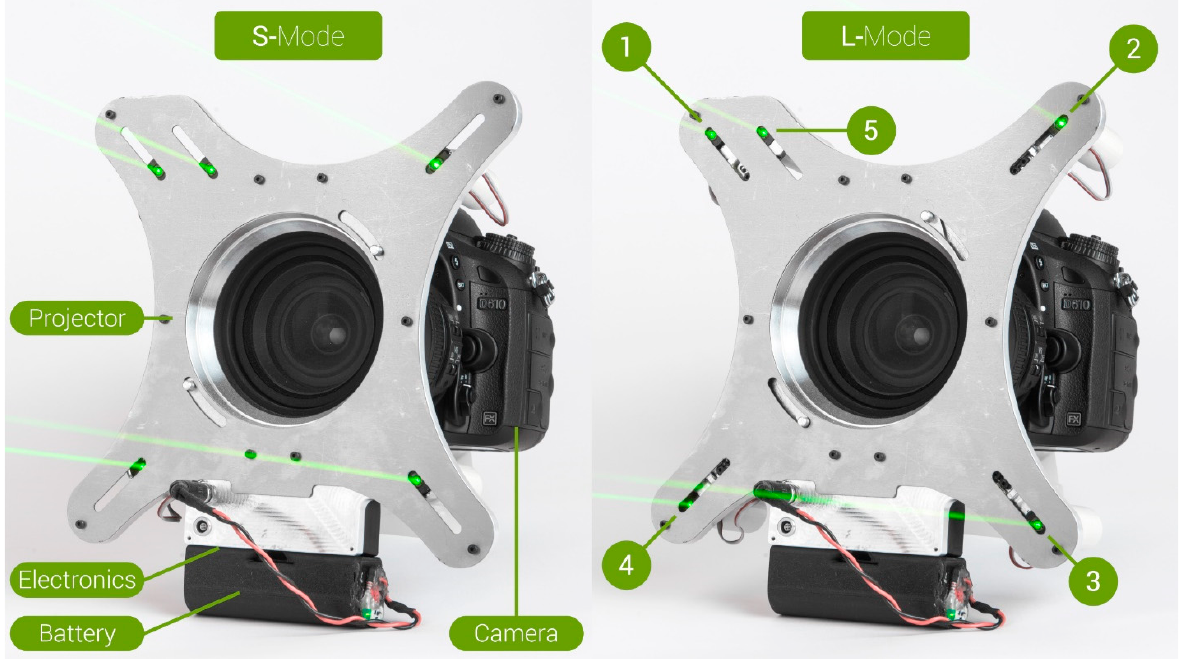
Figure 2. The FreeRef-1 projector mounted on a Nikon D610 camera with an 18–135 mm objective; however, this is not the objective used in the veri fi cation tests, which is shown in Figure 4. ( Left ) Lasers in S-mode, closest to the objective. ( Right ) Lasers in L-mode, furthest from the objective. Lasers 1 to 4 are the size reference lasers. Laser 5 is the mode laser that is used to detect the selected mode in the photos.